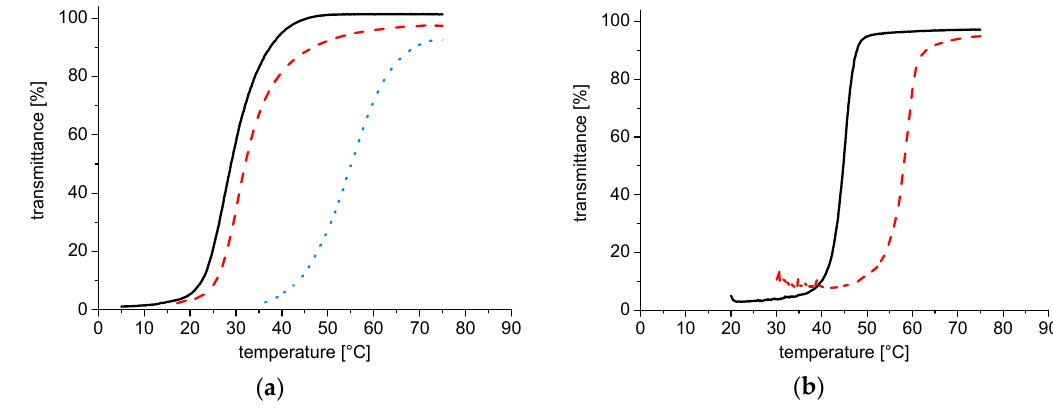
Figure 4. Temperature-dependent turbidity (cooling runs) of: ( a ) 30.0 g·L − 1 aqueous solutions of SPE-based block polymers PEG- b -PSPE-3 ( — ), PEG- b -PSPE-4 ( - - - - ) and PEG- b -PSPE-5 ( ----- ); ( b ) 3.00 g·L − 1 solutions of PZPE homopolymers PZPE-1 ( — ) and PZPE-2 ( - - - - ) in NSS.